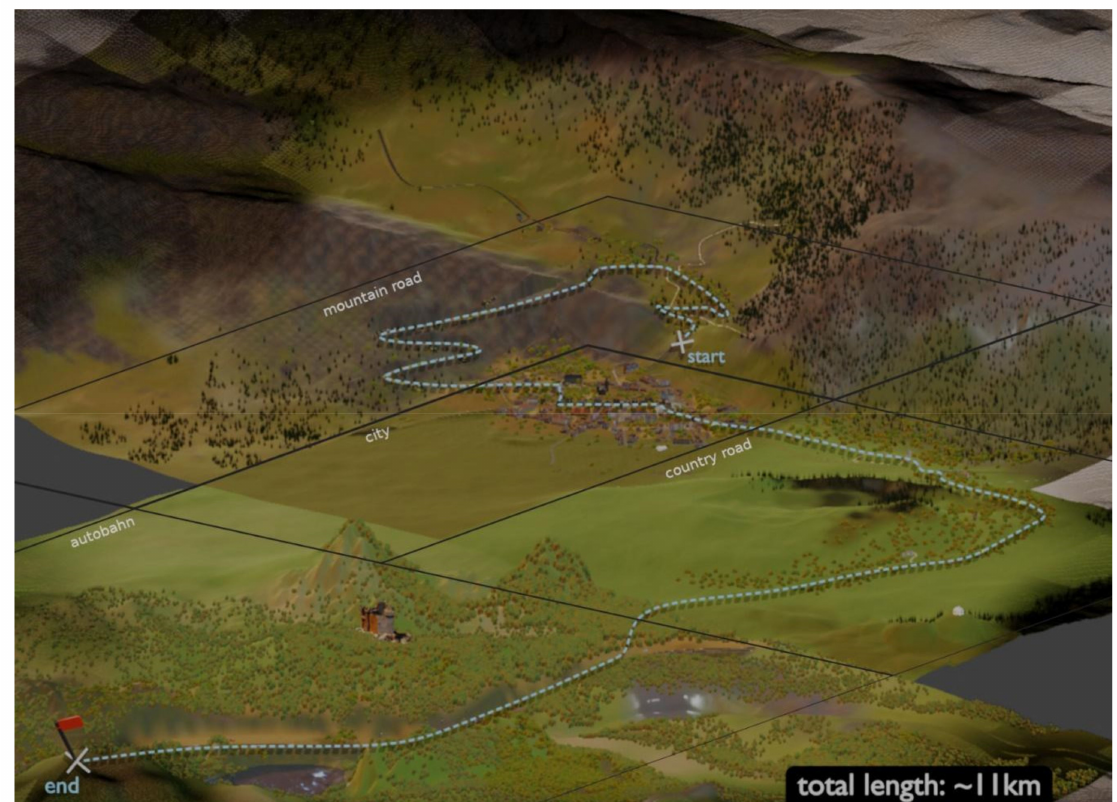
Figure 2. LoopAR map preview: mountain road (3.4 km), city (1.2 km), country road (2.4 km), and highway (3.6